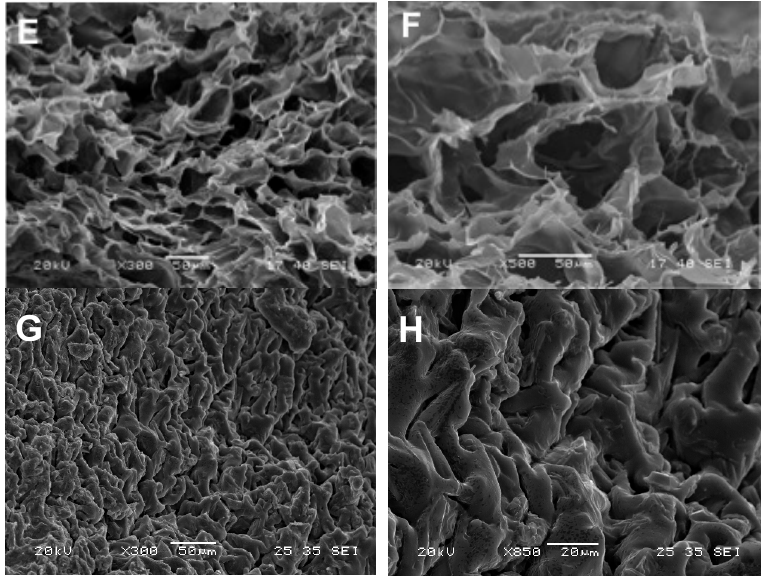
Figure 2. SEM images of ( A ) 0.7 mg/mL MWCNT-dopamine-PEG film surface; ( B ) high-resolution 0.7 mg/mL MWCNT-dopamine-PEG film surface; ( C ) 1.4 mg/mL MWCNT-dopamine-PEG film surface; ( D ) high-resolution 1.4 mg/mL MWCNT-dopamine-PEG film surface (MWCNTs are pointed out by red arrows); ( E ) PEG film surface; ( F ) high-resolution PEG film surface; ( G ) dopamine-PEG film surface; ( H ) high-resolution dopamine-PEG film surface.